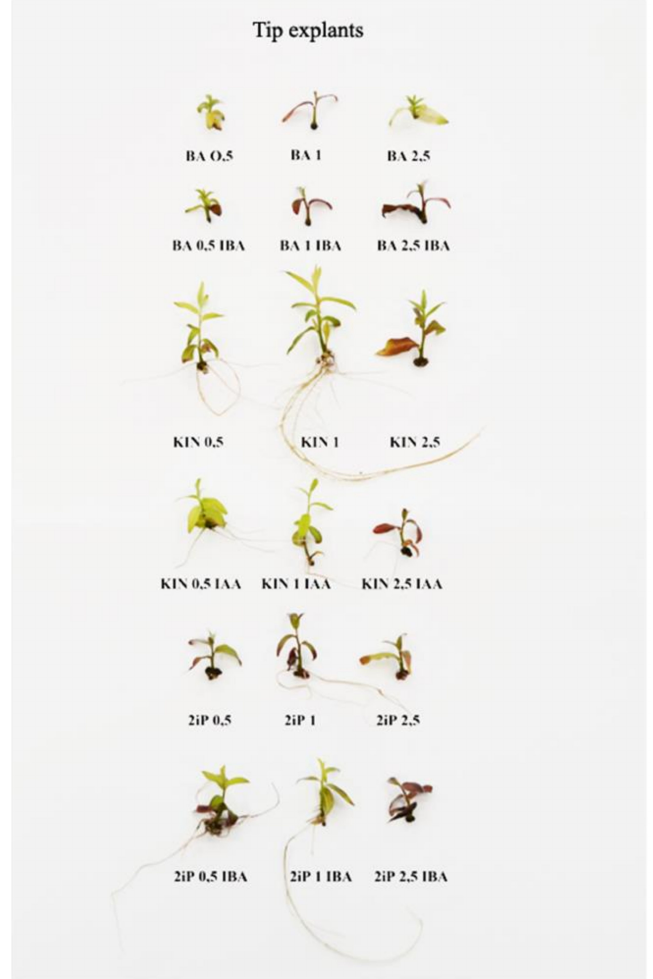
Figure 1. The representative plants obtained from S. lapponum shoot tip explants during in vitro cultivation on the media supplemented with di ff erent growth